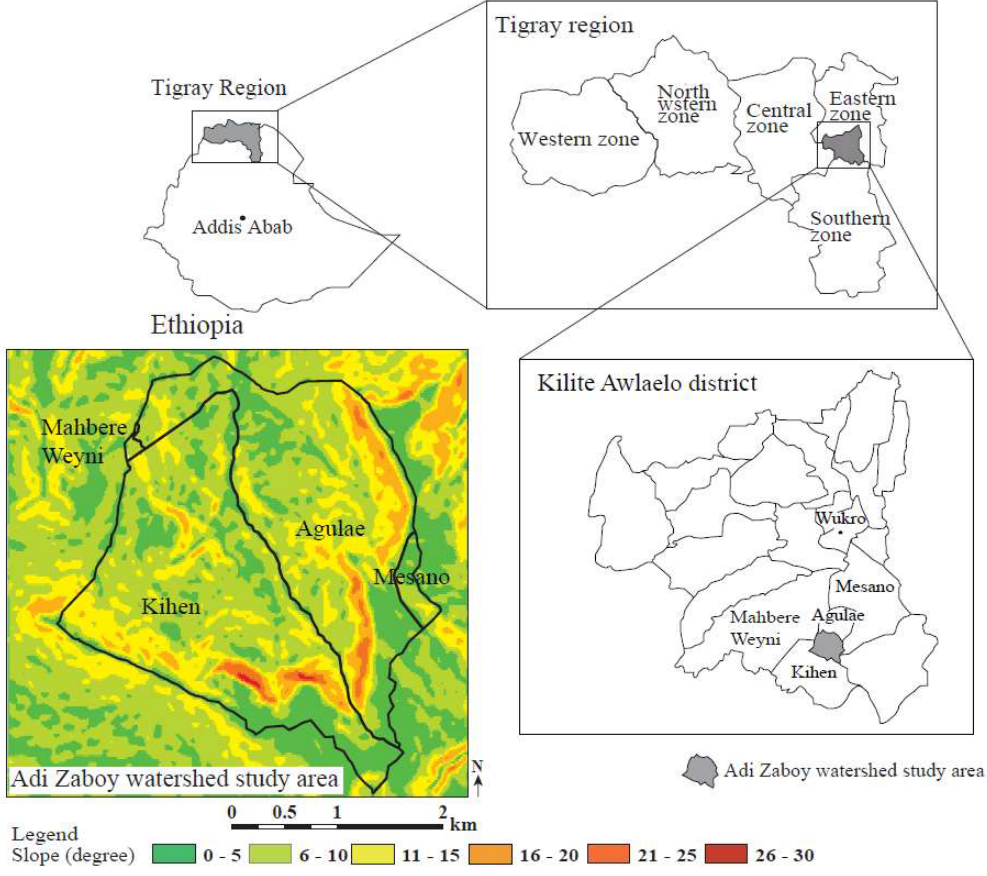
Figure 1. Location of the Adi Zaboy watershed study area, Agulae town, and the Kihen community in the Kilite Awlaelo district, eastern zone, Tigray region in northern Ethiopia and topography of the Adi Zaboy watershed.